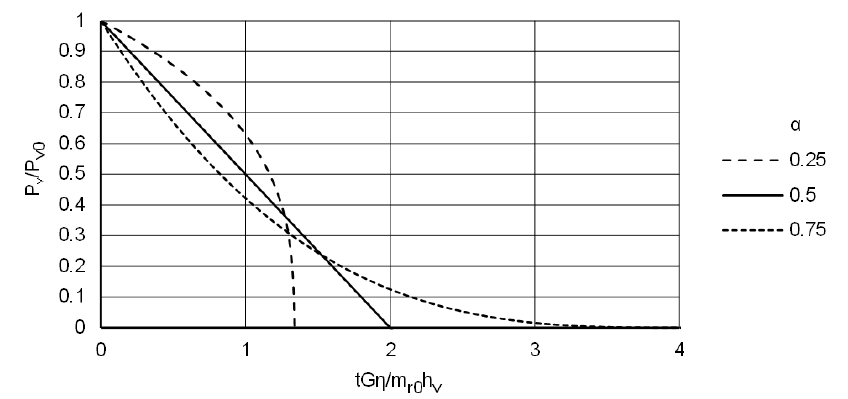
Figure 8. Relative enthalpy flow of steam as a function of dimensionless time.